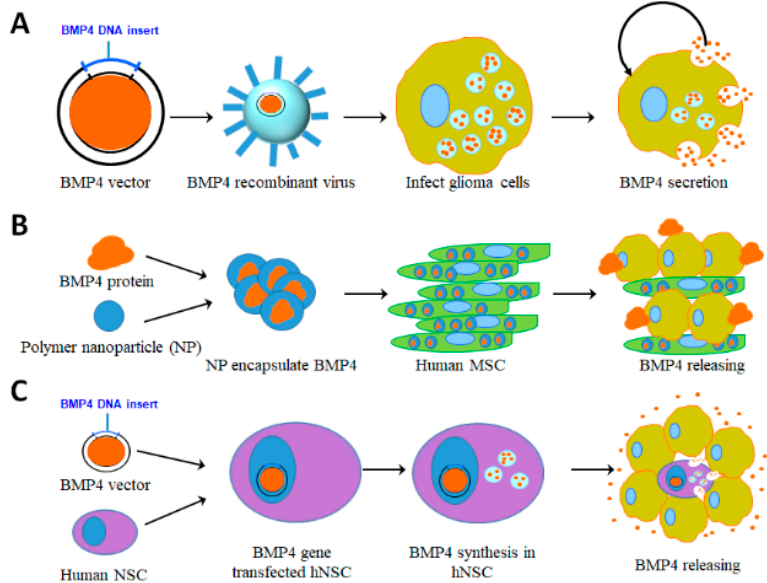
Figure 5. Peptide amphiphile (PA) nanostructures are novel biocompatible materials for BMP4 delivery. ( A ) Molecular structure of a glycosylated PA molecule and schematic of the self-assembled glycosylated PA nanofiber. The grey molecular region guides the self-assembly process into nanofibers, the blue molecular region contains the tri-sulfated monosaccharide responsible for protein binding actions. ( B ) SEM of glycosylated PA nanofiber bundles after exposure to blood proteins for 5 min. ( C ) Higher magnification of nanofibers with white arrows indicating a rigid surface texture resulting from proteins binding to the fiber surface. (Figures provided by Dr. Samuel Stupp with permission for